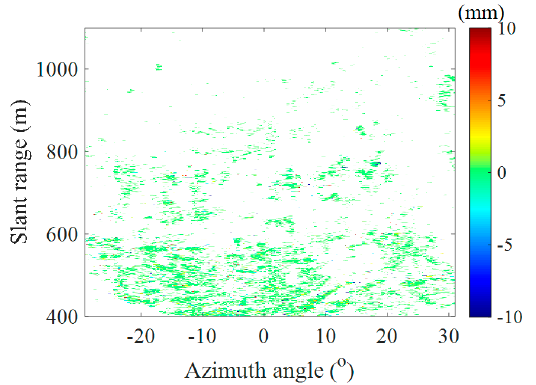
Figure 17. Cumulative deformation map during the monitoring period of 10 days.